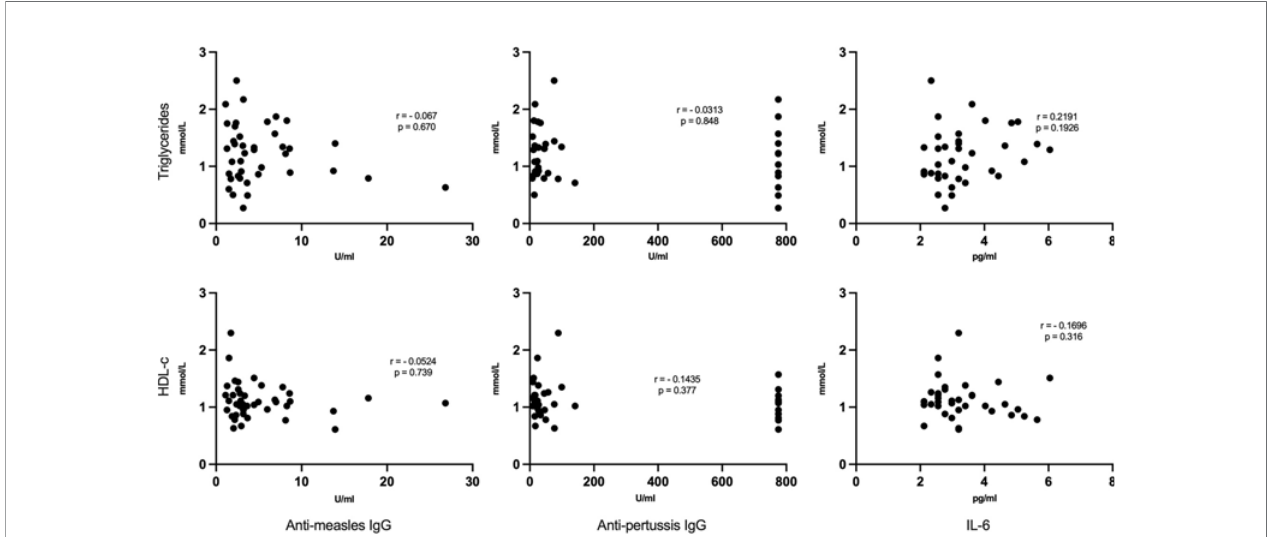
FIGURE 5 | No correlation between lipid levels and anti-measles, anti-pertussis plasma IgG titers or IL-6: Each dot represents respective lipid [triglycerides (upper panels) and HDL-c (lower panels)] and vaccine titers/IL-6 serum levels. Statistical analysis was performed using the Spearman ’ s rank correlation